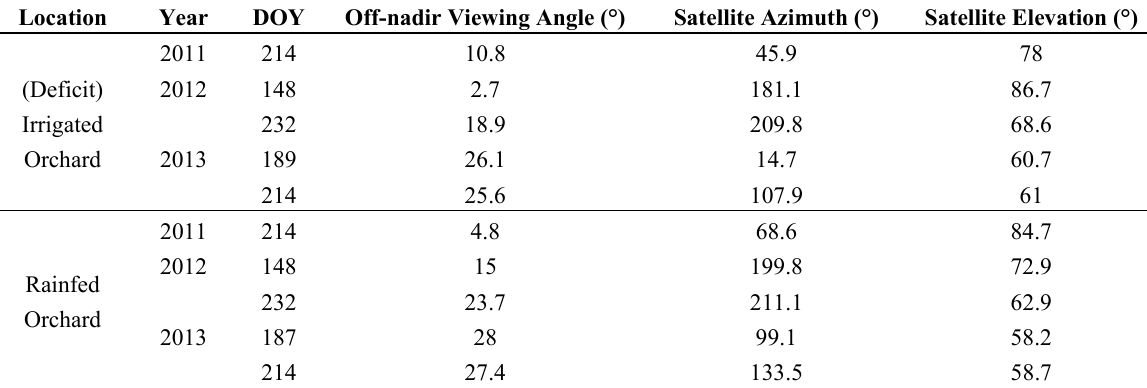
Table 2. Metadata of WorldView-2 acquisitions used in this